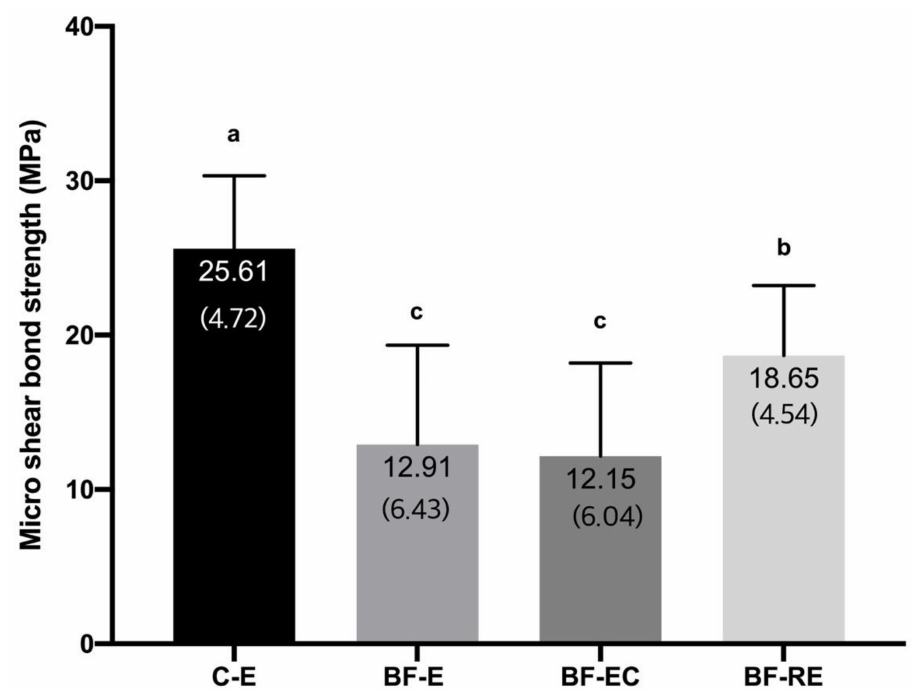
Figure 3. Micro-shear bond strength of the experimental groups (C-E: no biofilm formation and treatment with acid etching, BF-E: biofilm formation and treatment with acid etching, BF-EC: biofilm formation and treatment with acid etching and chlorhexidine, and BF-RE: biofilm formation and treatment with pumice rubbing and acid etching). Numbers in parentheses represent standard deviation values. Di ff erent letters (a, b, c) on top of the bar mean statistically significant di ff erences between groups ( p <